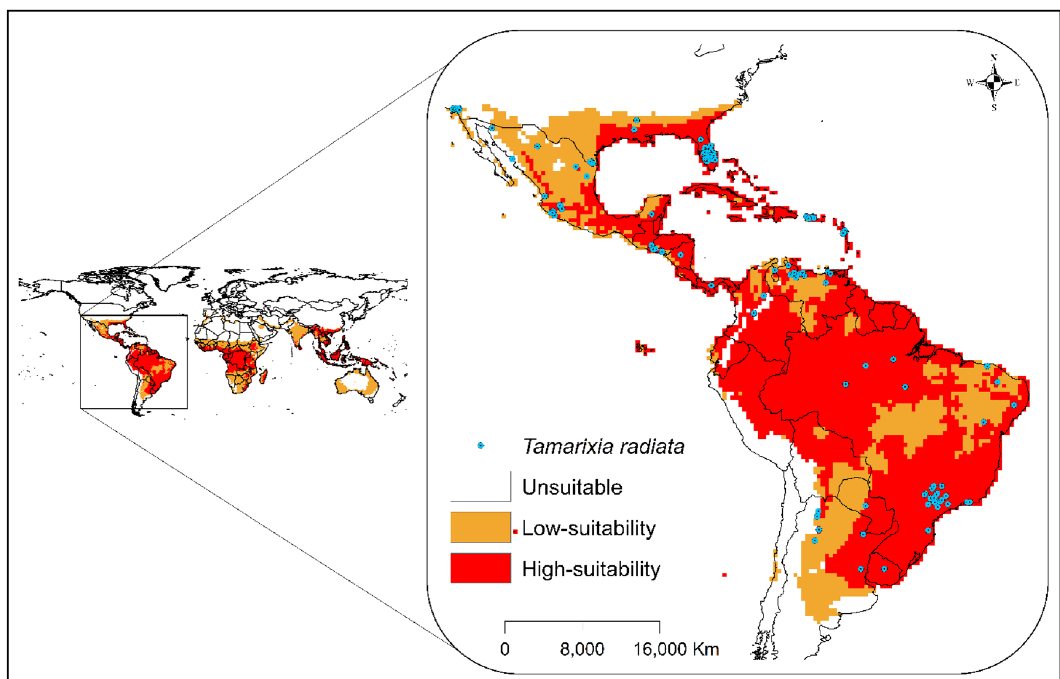
Figure 3. Current and potential distribution of T. radiata in the model’s validation region, based on the EI index. ESRI ArcMap 10.2.2 (https:// suppo rt. esri. com/ en/ Produ cts/ Deskt op/ arcgis- deskt op/ arcmap/ 10-2- 2# downl oads) and CLIMEX 4.0.0 (https:// www. hearne. softw are/ Softw are/ CLIMEX- DYMEX/ Editi